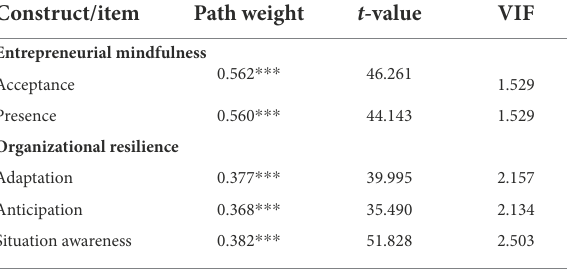
TABLE 6 Evaluation of the inner formative measurement model.